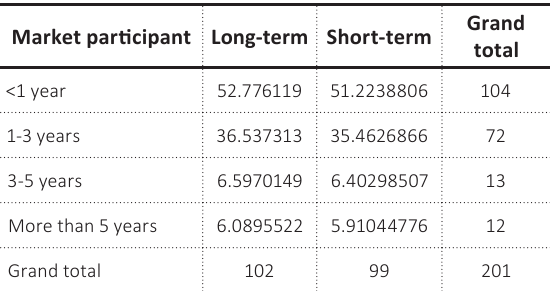
Table 6. Expected frequencies of the impact of the years of market participation on investment of short and long-term investors